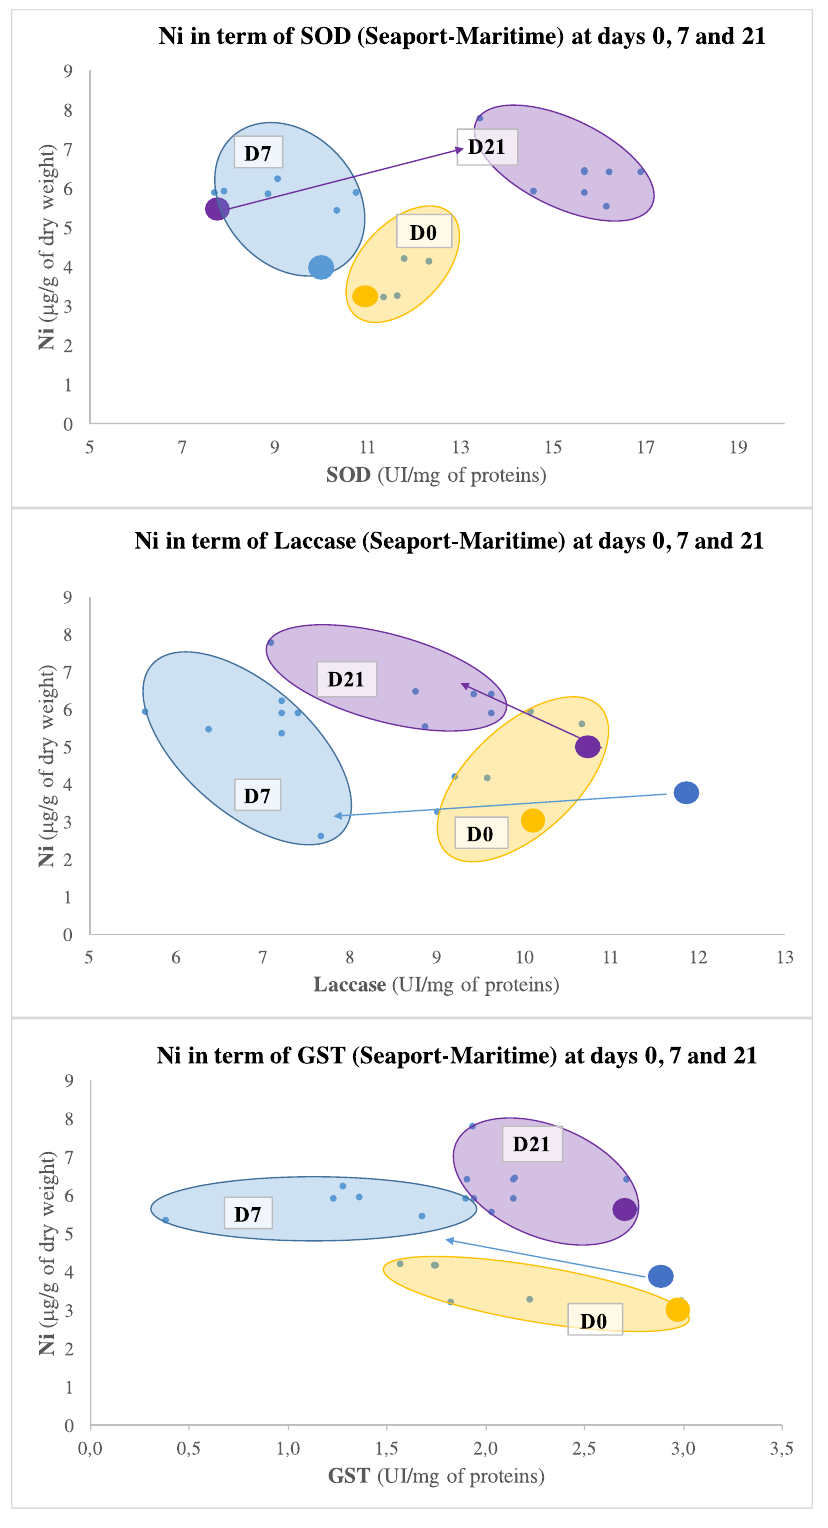
PLOS ONE | https://doi.org/10.1371/journal.pone.0198255 June 25,